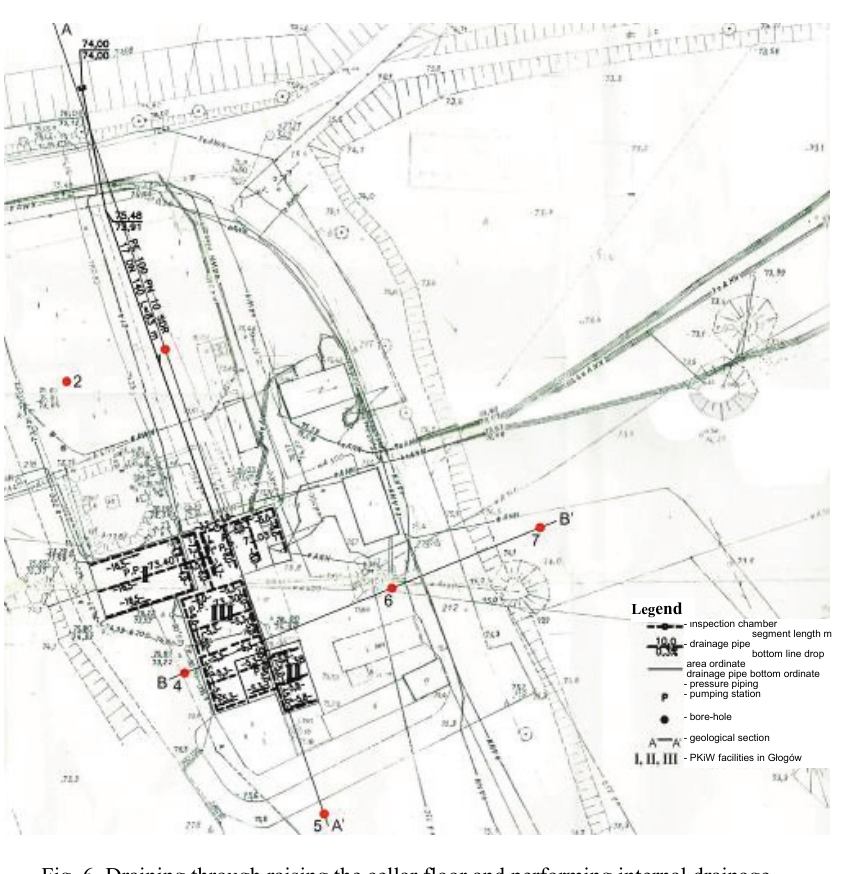
Fig. 6. Draining through raising the cellar floor and performing internal